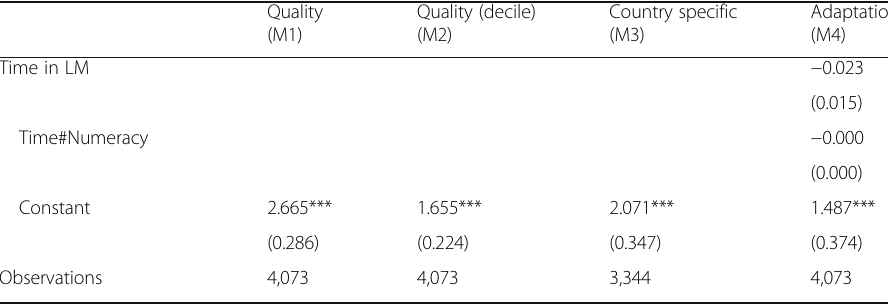
Table 4 Logistic regression on the probability of being unemployed. Explanations for the ethnic gap between natives and immigrants settled in Spain